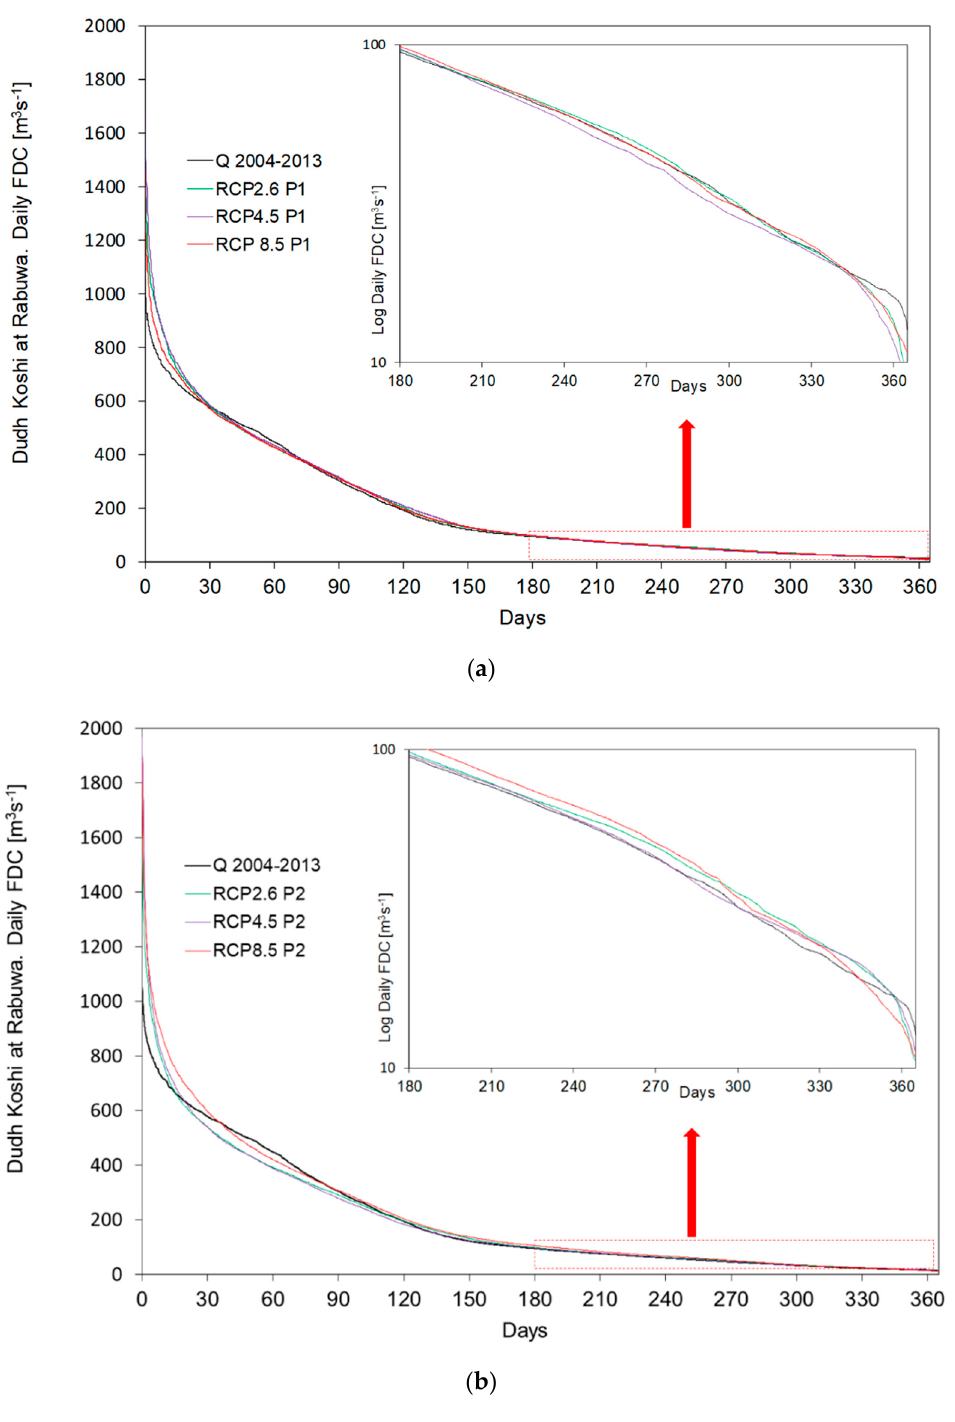
Figure 8. Rabuwa bazar. Flow duration curves. CR, and average (three GCMs) for each RCP. ( a ) P1 . ( b ) P2 . Logarithmic values are used in the window to highlight low flows for longest durations.